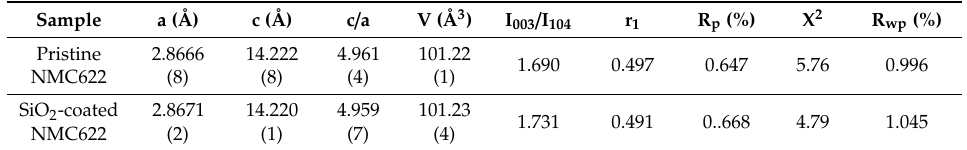
Figure 1. XRD patterns of ( a ) pristine and ( b ) SiO 2 -coated NMC622 powders and their Rietveld refinement results. Table 2. Lattice parameters and cation mixing indicators of pristine and SiO 2 -coated NMC622 powders.